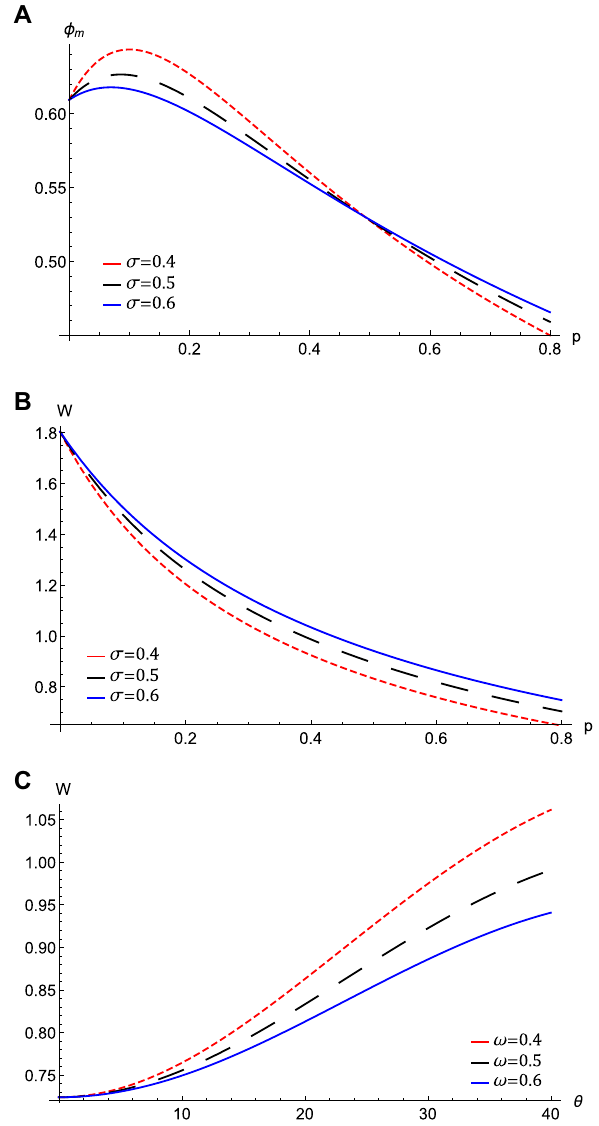
Figure 3. The variation of the QIASWs ( A ) the amplitude φ m against p for different values of σ at ω = 0.5 , θ = 20 , ( B ) the width W against p for different values of σ at ω = 0.5 , θ = 20 , ( C ) the width W against θ for different values of ω at σ = 0.5 , p = 0.7 with all at H e = 0.4 , and H p = 0.6